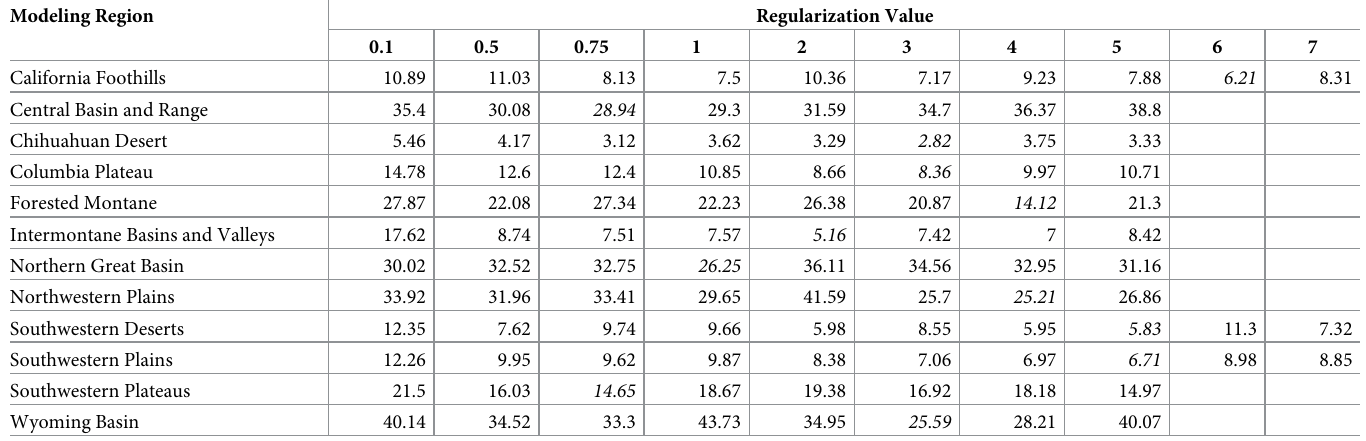
Table 4. Mean squared prediction error (MSE) among regularization multiplier values for each modeling regions’ final golden eagle nesting area model. The lowest MSE value is italicized and has gray shading. For the Southwestern Plains, Southwestern Deserts, and California Foothills modeling regions, the lowest MSE was found at regularization values of 5 (the largest value we initially evaluated), so we evaluated two larger regularization multiplier values (6 and 7) to determine whether MSE contin- ued to decline with increasing